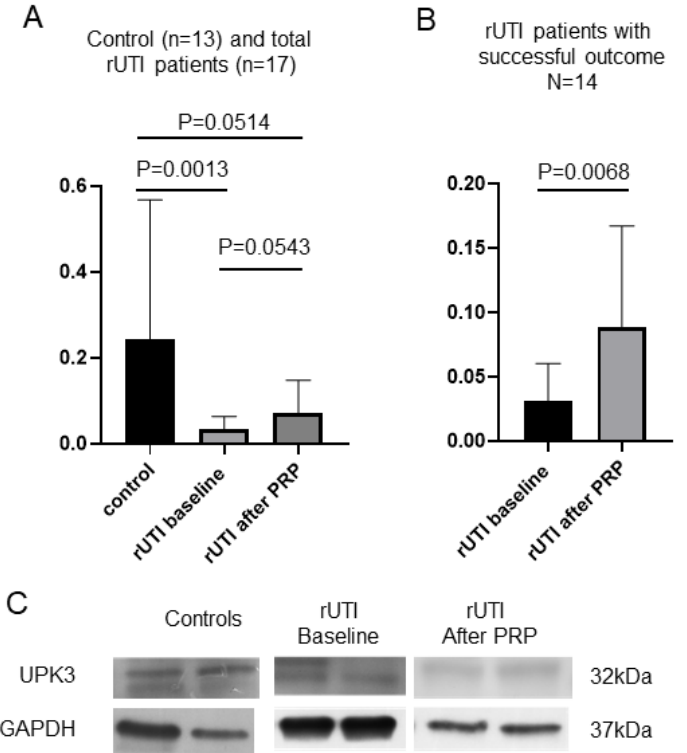
Figure 4. Western blot results of UPK3. ( A ) The UPK3 expression quantification result of control subjects ( n = 13), patients with rUTI at baseline, and patients with rUTI after PRP injections ( n = 17). The expression of UPK3 was significantly higher in the control bladder specimens than in the rUTI specimens at baseline ( p = 0.0013) but was not significantly higher than that in rUTI specimens after PRP injections ( p = 0.0514, nonparametric independent t -test). The expression of bladder UPK3 was also not significantly different between rUTI at baseline and after PRP injections ( p = 0.0543, non- parametric paired t -test). ( B ) The expression of UPK3 in the patients with rUTI with successful PRP injection outcome. The expression of UPK3 was increased after PRP injection ( p = 0.0068, nonpara- metric paired t -test). ( C ) The representative Western blotting bands from the patients with rUTI and control subjects. All 29 patients provided urine samples at baseline, but only 14 patients (10 successful and 4 unsuccessful outcomes) provided urine at 1 month after the fourth PRP injection. AS compared with healthy controls, the baseline urinary inflammatory cytokine IL-6 and IL-8 levels were significantly higher in patients with rUTI, whereas the IL-2 level was sig- nificantly lower (Figure 5A). The baseline levels of urinary growth factors, including NGF and VEGF, were significantly lower in patients with rUTI than in healthy controls (Figure 5A), although the BDNF level was significantly higher. The urinary BDNF level was de- creased compared with baseline, whereas the level of the other cytokine did not exhibit a significant change (Figure 5B).